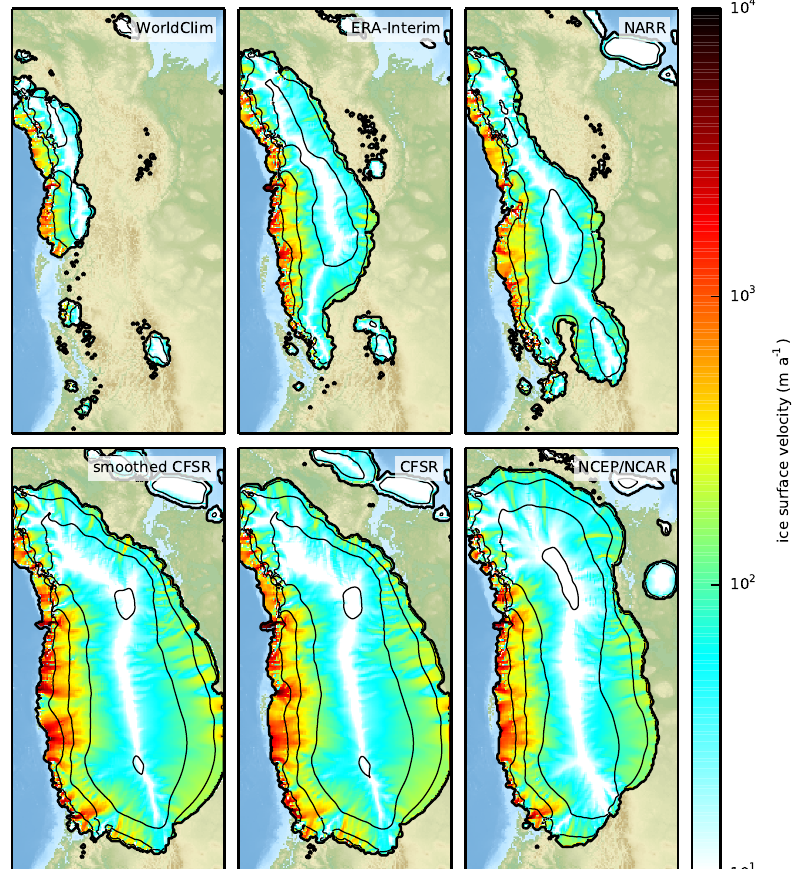
Figure 7. Ice surface topography (1km contours) and velocity (myr − 1 ) after 10kyr under a climate 5 ◦ C colder than present for each climate forcing